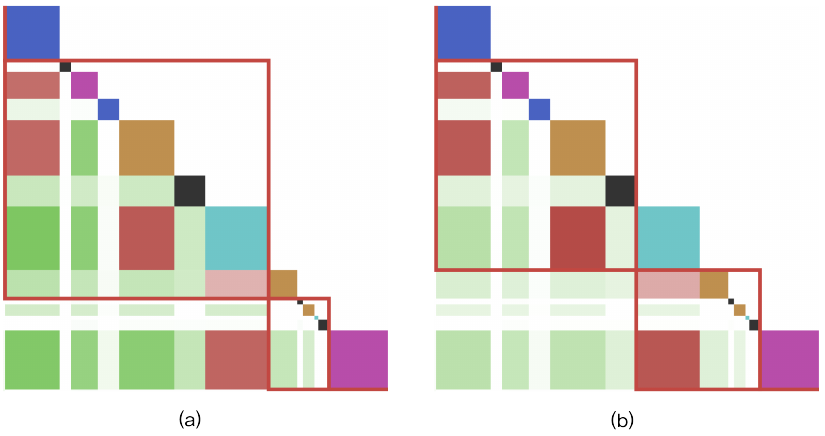
Figure 13. Before ( a ) and after ( b ) chain of arguments and counterarguments is applied to concep- tual similarities. By applying the weight of the metric that quantifies the chain of arguments and counterarguments, the transcript is segmented based on the corresponding conceptual similarities of arguments and